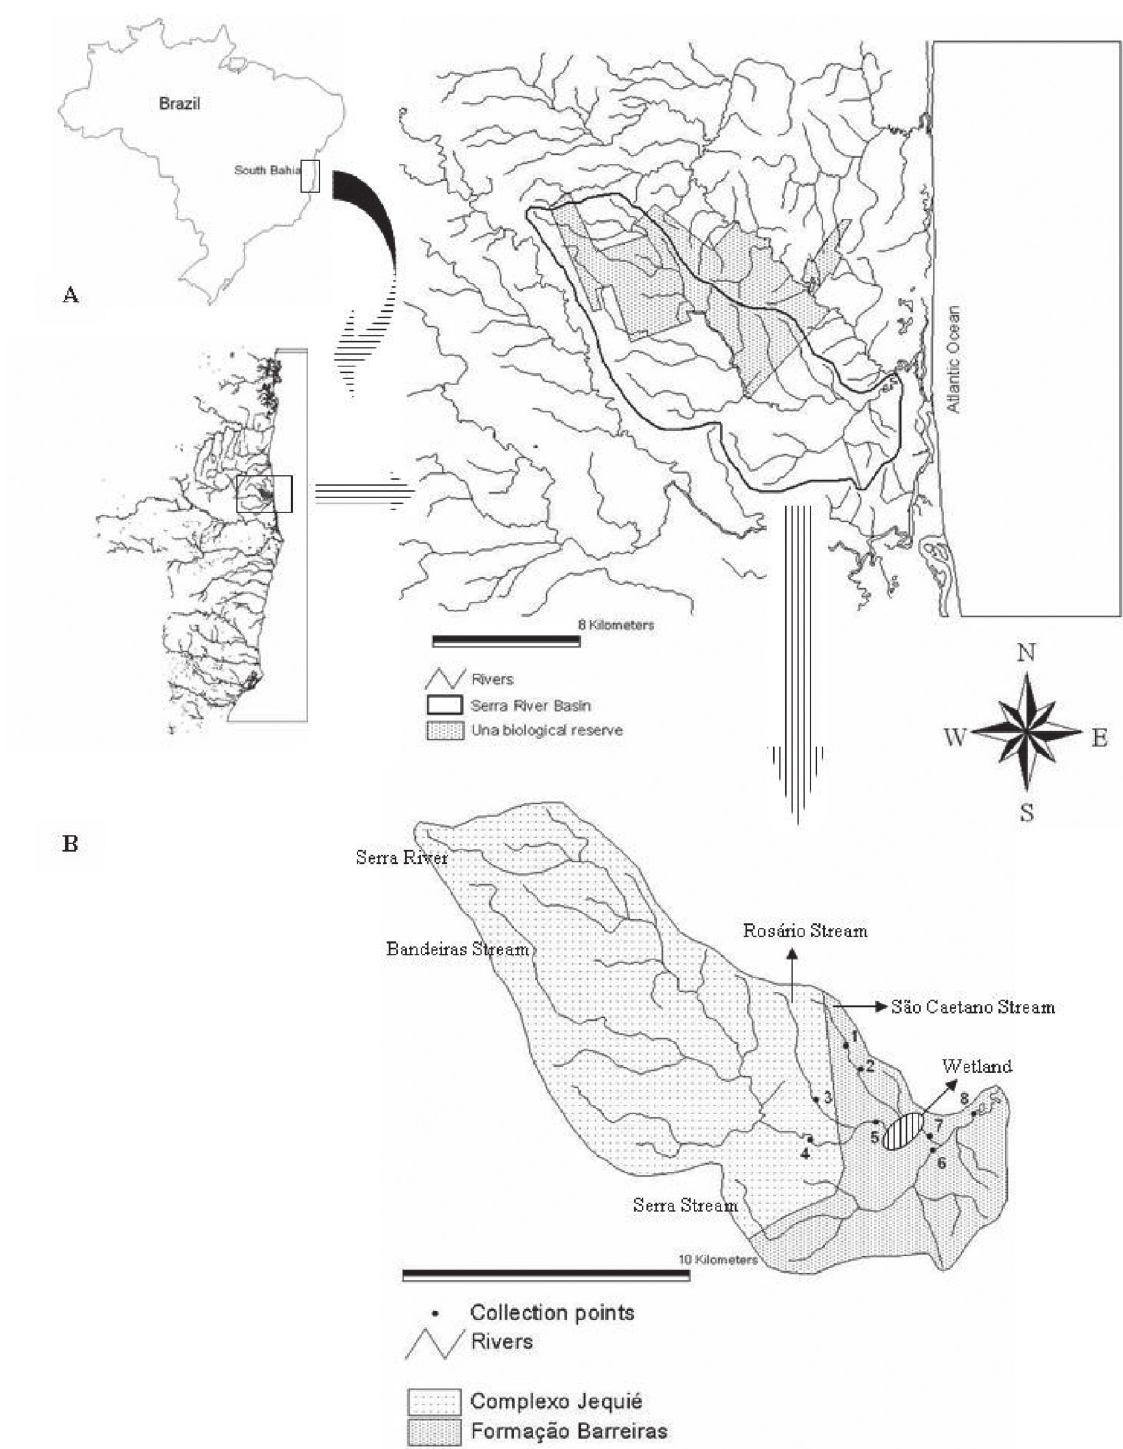
Figure 1 - Map of Rio da Serra Basin. (A) Location of the basin with highlight for the Una Biological Reserve. (B) Hydrography of the basin with the location of the eight stations, and the distribution of the two present geological types: the Jequié Complex at west and the Barreiras Formation at east. Modified from Landau et al.